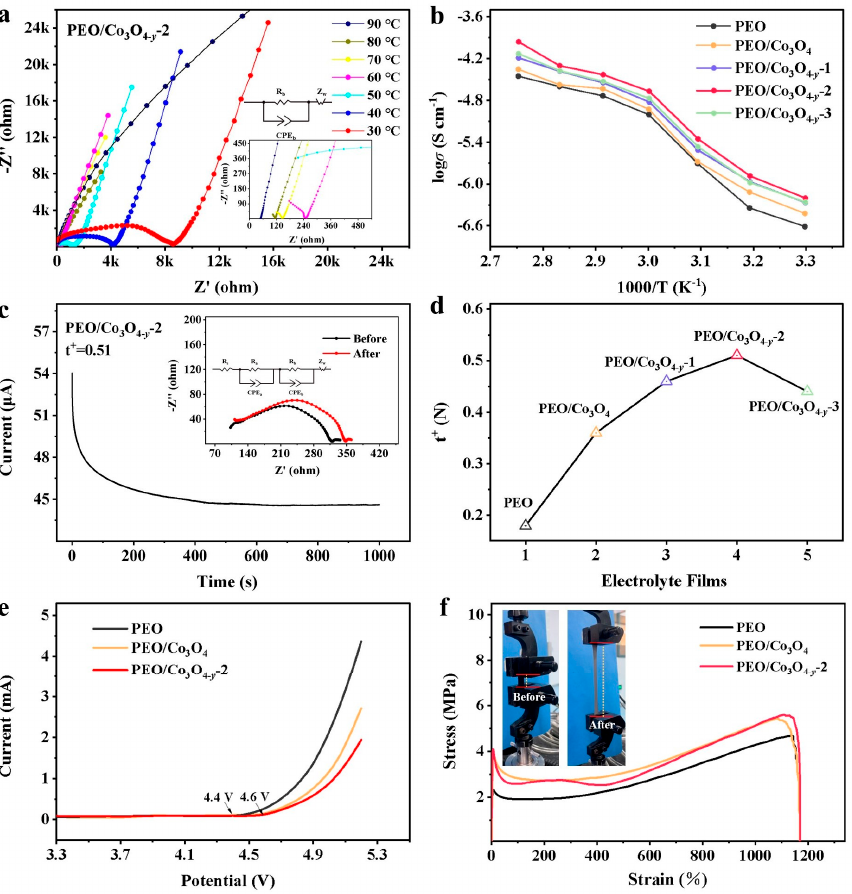
Figure 4. Electrochemical and physical performance of the electrolyte fi lms. ( a ) EIS spectra of symmetric SS||PEO/Co 3 O 4- y − 2||SS cell and ( b ) Arrhenius plots of symmetric SS||SPEs||SS cells using PEO, PEO/Co 3 O 4 and PEO/Co 3 O 4- y − x ( x = 1, 2 and 3) as the electrolyte fi lms, at avarious temperatures from 30 to 90 ◦ C. ( c ) Chronoamperometry curves with a potential step of 20 mV of symmetric Li||PEO/Co 3 O 4- y − 2||Li cell at 80 ◦ C. ( d ) Li + transference number plot of Li||SPEs||Li cells using PEO, PEO/Co 3 O 4 and PEO/Co 3 O 4- y − x ( x = 1, 2 and 3) as the electrolyte fi lms. ( e ) LSV curves at 0.1 mV s − 1 of asymmetric SS||SPEs||Li cells, and ( f ) stress–strain curves of PEO, PEO/Co 3 O 4 and PEO/Co 3 O 4- y − 2 fi lms. Inset of Figure 4c: EIS spectra of the cell before and after polarization. Inset of Figure 4f: Digital photos of PEO/Co 3 O 4- y − 2 at initial and tension states. To evaluate the electrochemical stability of the electrolyte fi lms, liner sweep voltammetry (LSV) curves of SS||SPEs||Li cells were conducted. As shown in Figures 4e and S1, the cells using PEO/Co 3 O 4- y − x ( x = 1, 2 and 3) and PEO/Co 3 O 4 fi lms run stably with a higher oxidative stability >4.6 V than that using PEO fi lm at ~4.4 V. The lower current density of the cells using PEO/Co 3 O 4- y − 2 than PEO/Co 3 O 4 fi lms at 5.2 V further supports its stronger high-voltage tolerance [45,46]. Figure 4f compares the mechanical properties of the electrolyte fi lms with the stretch rate of 50 mm min − 1 . As can be seen, all fi lms exhibit the drecreased stress at initial states mainly due to the overcoming of the yield point. Despite the similar fracture limit length of the three electrolyte fi lms, the yielding strength of PEO/Co 3 O 4- y − 2 and PEO/Co 3 O 4 fi lms can reach ~4.0 MPa, which is much higher than that of the PEO fi lm with ~2.1 MPa. After ~1185% stretching, moreover, the tensile strength of PEO/Co 3 O 4- y − 2 and PEO/Co 3 O 4 fi lms can reach ~5.1 and 5.2 MPa, respectively, which is